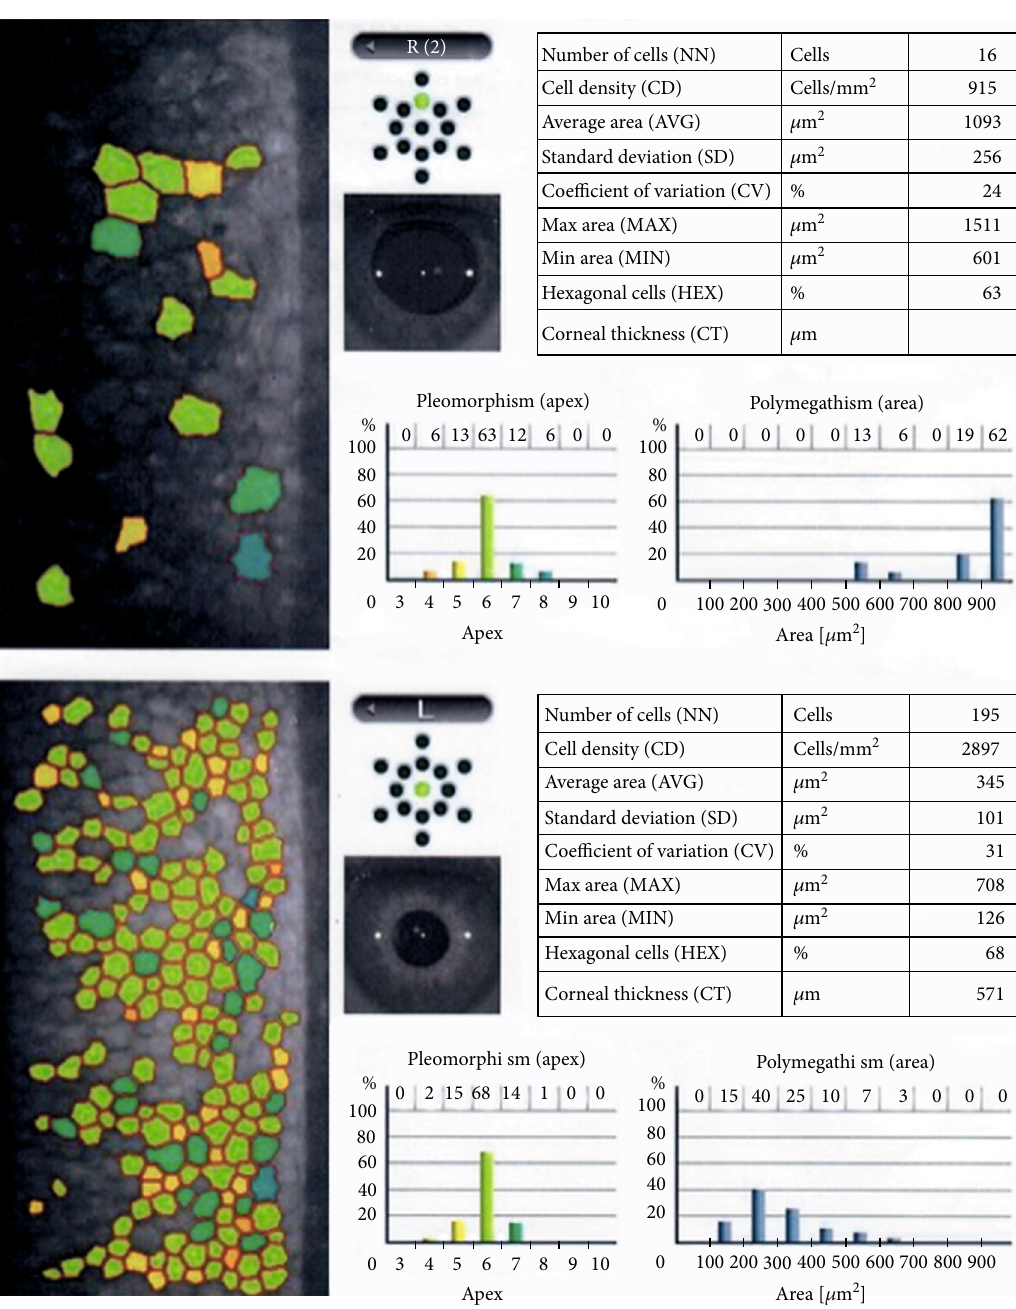
Figure 4: Specular microscopy of both eyes, showing a signi fi cant decrease in cell count and a clear increase in cell area in the right eye, while values remain normal in the left eye. Please also note the di ff erence in pupil size between the right (UZS) and left (normal)